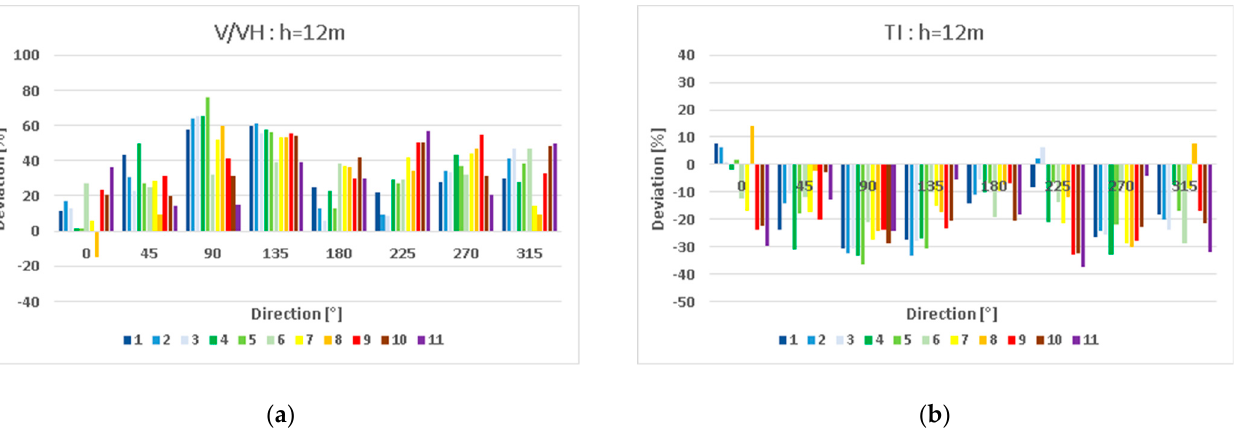
Figure 18. Mean absolute deviations of the wind ( a ) and turbulence intensity ( b ) per direction for the 11 probe validation points at height h = 12 m with WAsP Engineering.